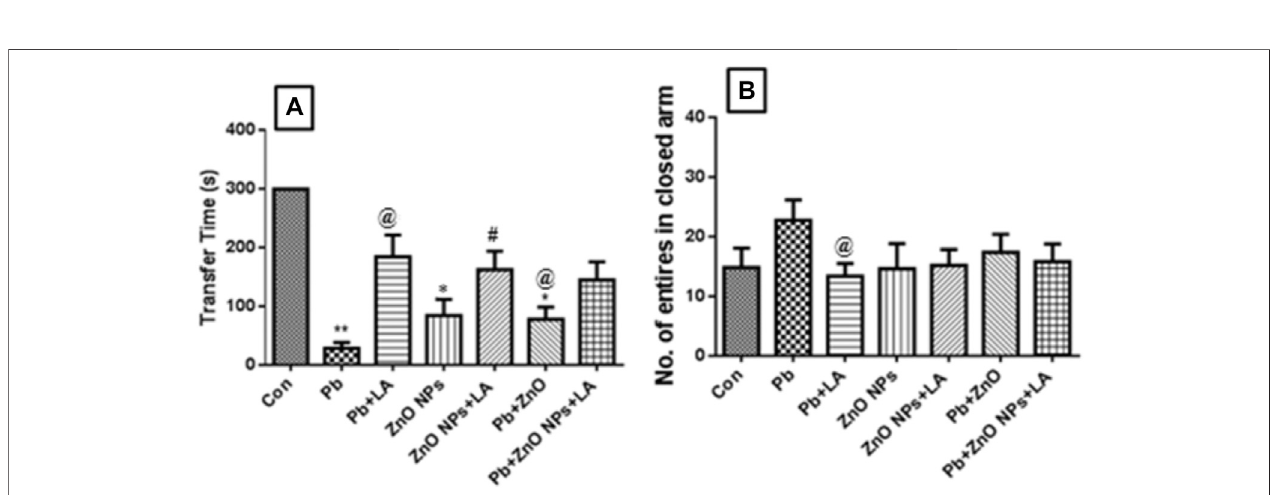
FIGURE4| Latencyoftransfertothedarkcompartment (A) .Numberofentriesintheclosedarm (B) .Allthevaluesareexpressedasmean ± SEM(n (cid:2) 5).* p < 0.05, ** p < 0.01 vs. control; @ p < 0.05 vs. lead; # p < 0.05 vs. ZnO NPs.